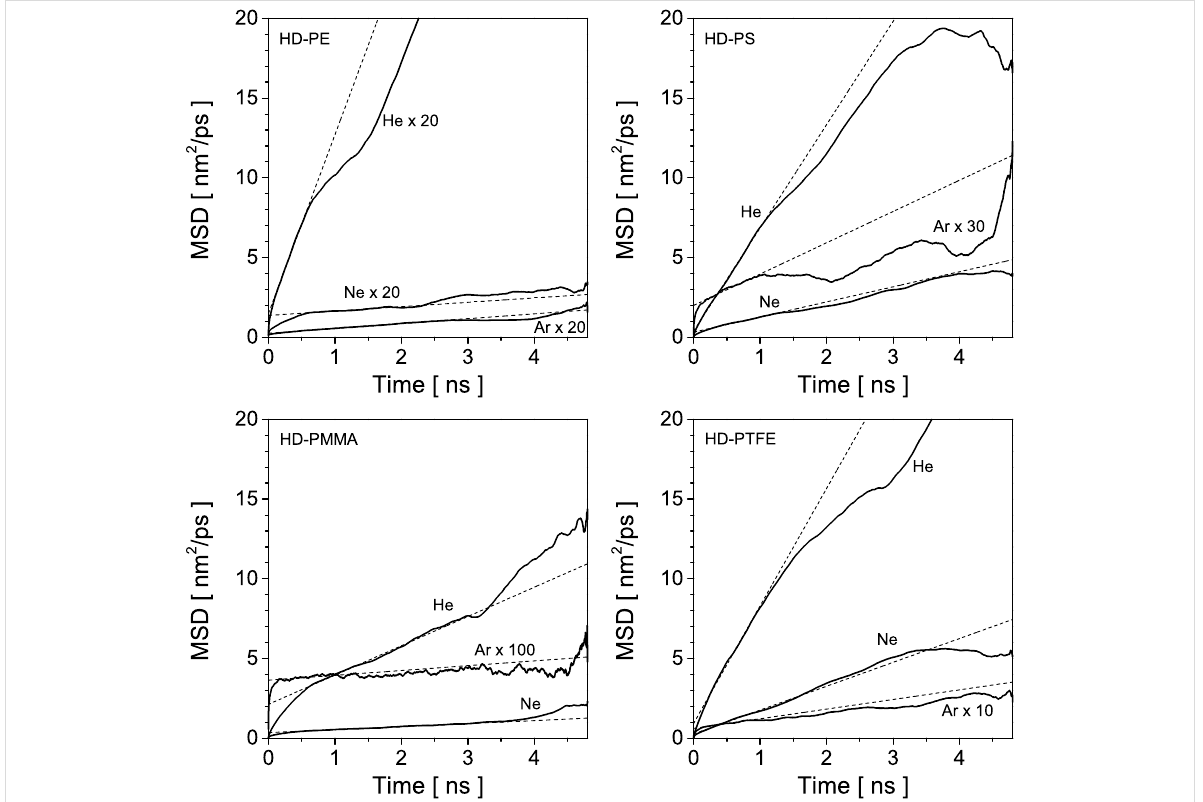
Figure 4: Mean square displacement (MSD) of helium, neon and argon at 300 K in a) HD-PE, b) HD-PS, c) HD-PMMA and d) HD-PTFE. For HD-PE all curves have been scaled up by a factor 20, for other polymers the curves for argon have been scaled up by a factor 10, 30 or 100 as is depicted on the each graph. The dashed lines show the linear fits to the